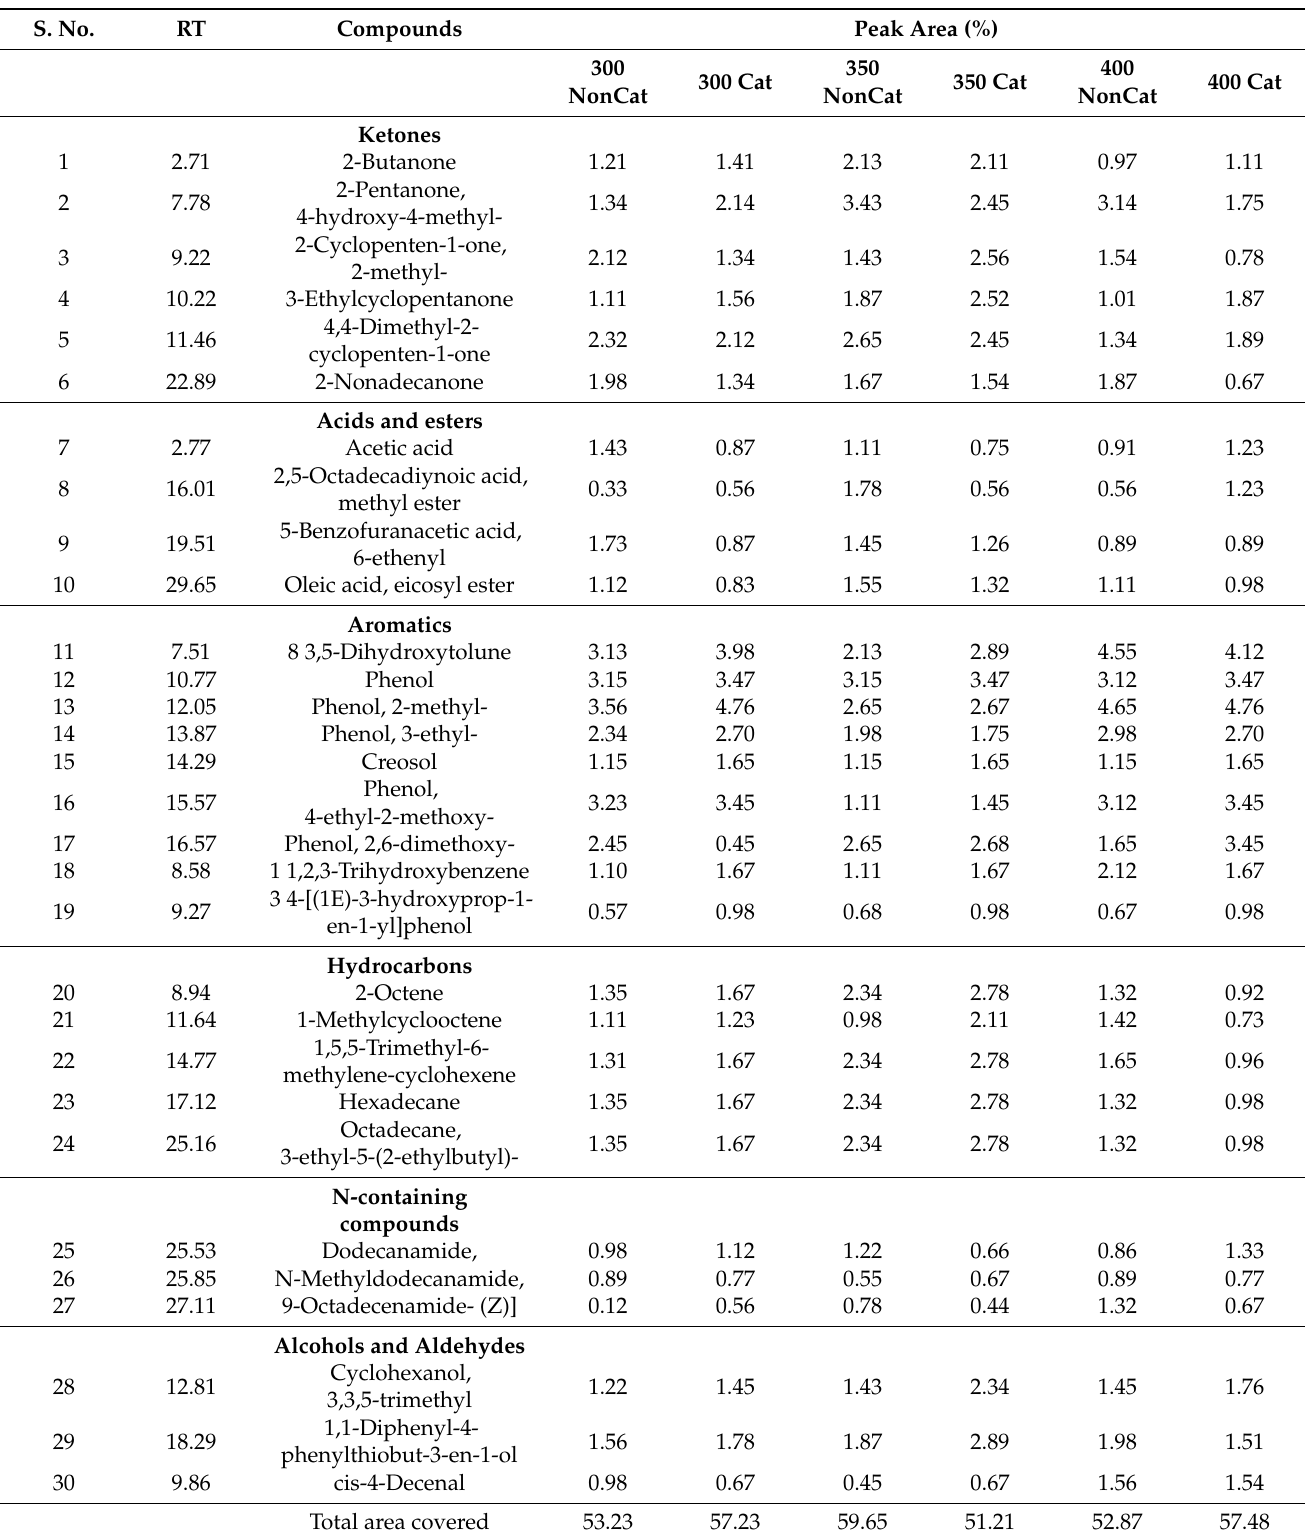
Table 3. Compound list of detected